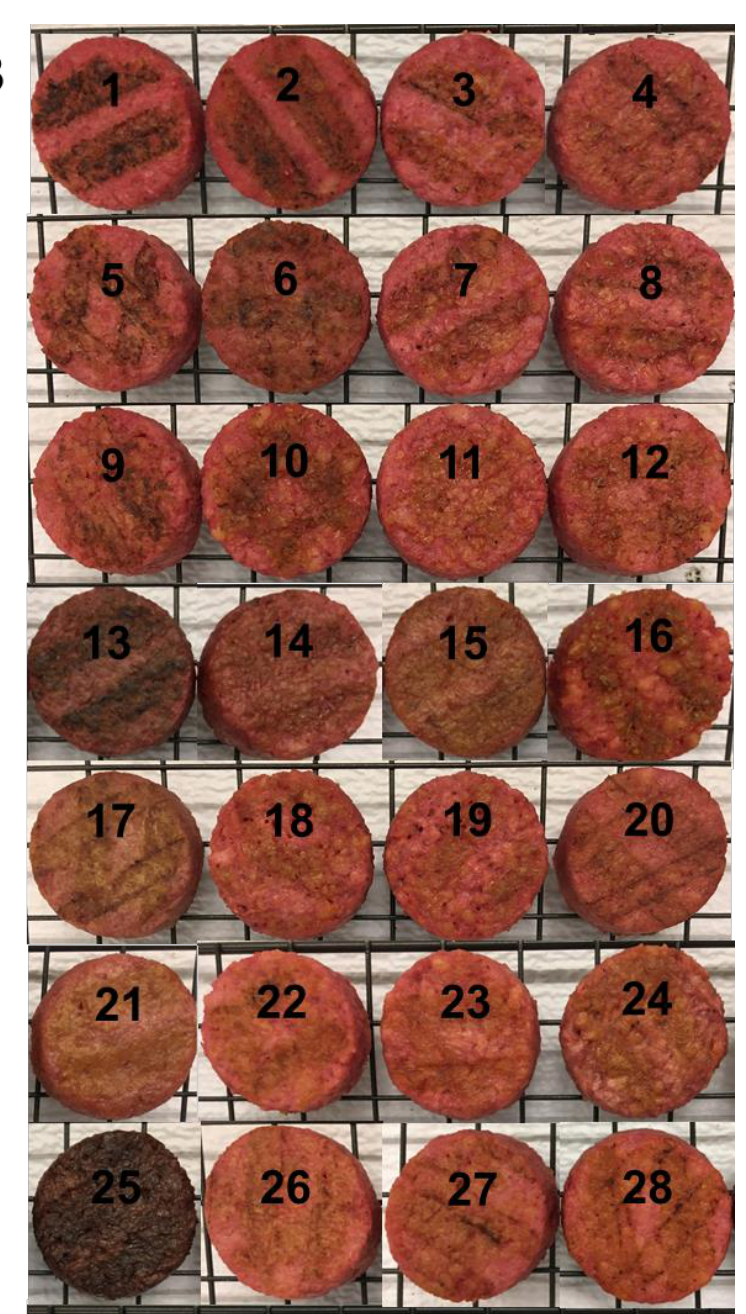
Figure 3. Pictures of TVP-based patties before ( A ) and after ( B ) cooking. Patty types: 1 – 14 produced from textured soy proteins; 15 – 21 from textured pea proteins; 22 – 25 from textured wheat gluten; 26 from textured chickpea protein; 27 made from textured pea/chickpea mixed proteins; and 28 made from textured pea/navy bean mixed proteins.